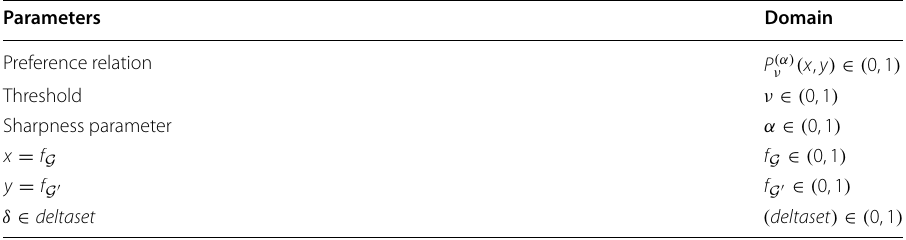
Table 2 The range of the parameters values in the preference relation